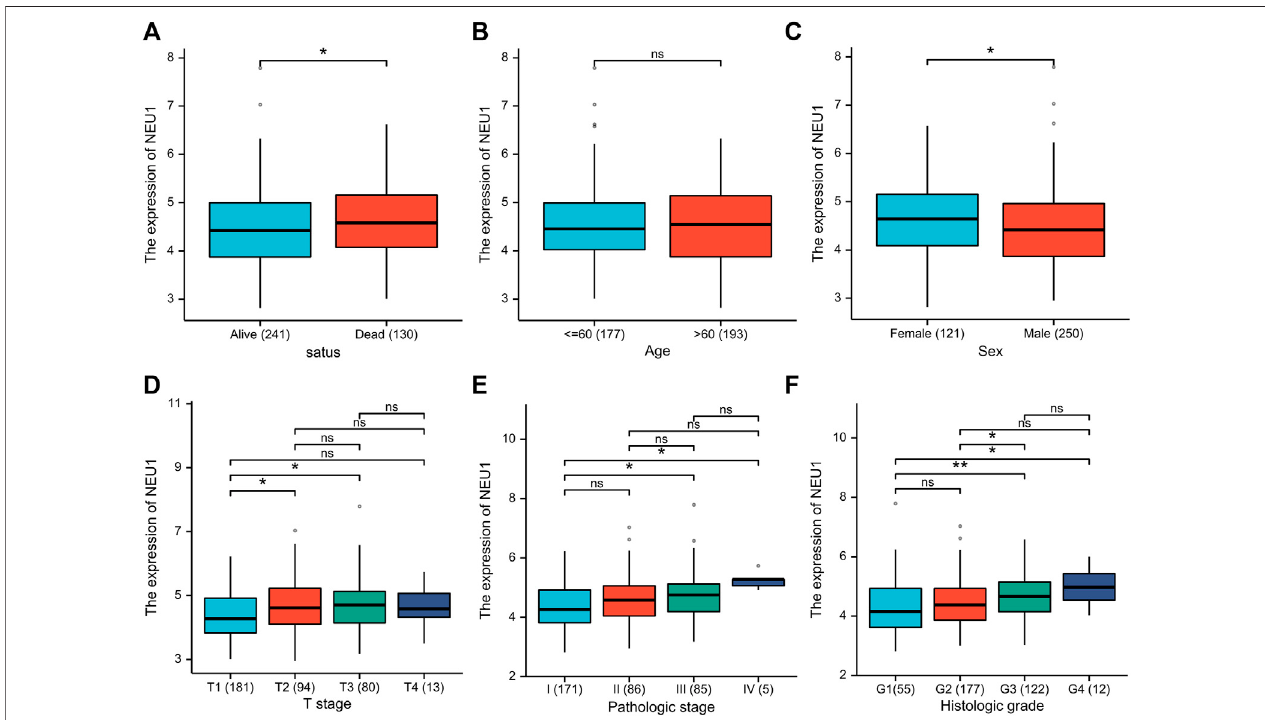
FIGURE 4 | The relationship between the NEU1 expression and clinicopathologic parameters (TCGA dataset) (A) Relative expression of NEU1 in alive status or deadstatus (B) RelativeexpressionofNEU1inyoungerpatients( ≤ 60)orelderpatients( > 60) (C) RelativeexpressionofNEU1infemaleormale (D) Relativeexpressionof NEU1 in T stage 1, 2, 3, or 4 (E) Relative expression of NEU1 in pathologic stage I, II, III, or IV (F) Relative expression of NEU1 grade 1, 2, 3, or 4. ns represents p ≥ 0.05; * represents p < 0.05, and ** represents p < 0.01.